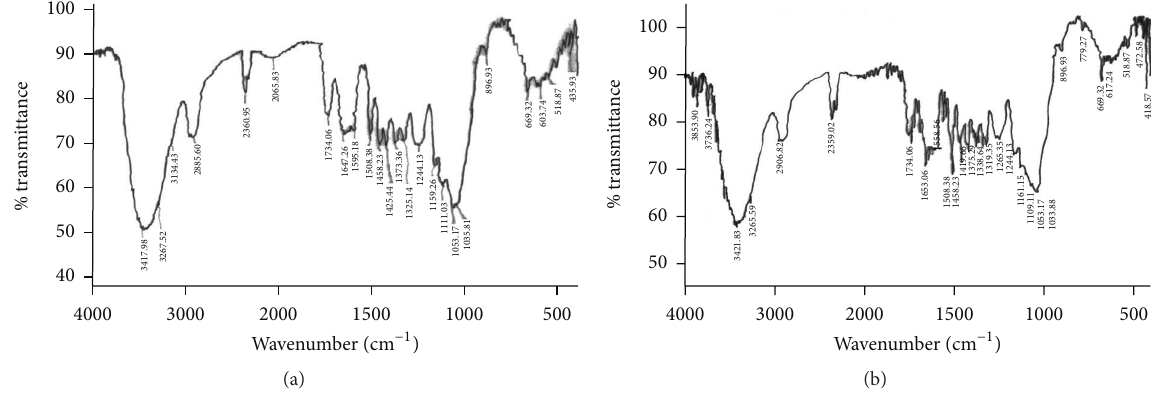
Figure 2: FTIR spectra of RSD (a) before and (b) after adsorption of Acid Blue